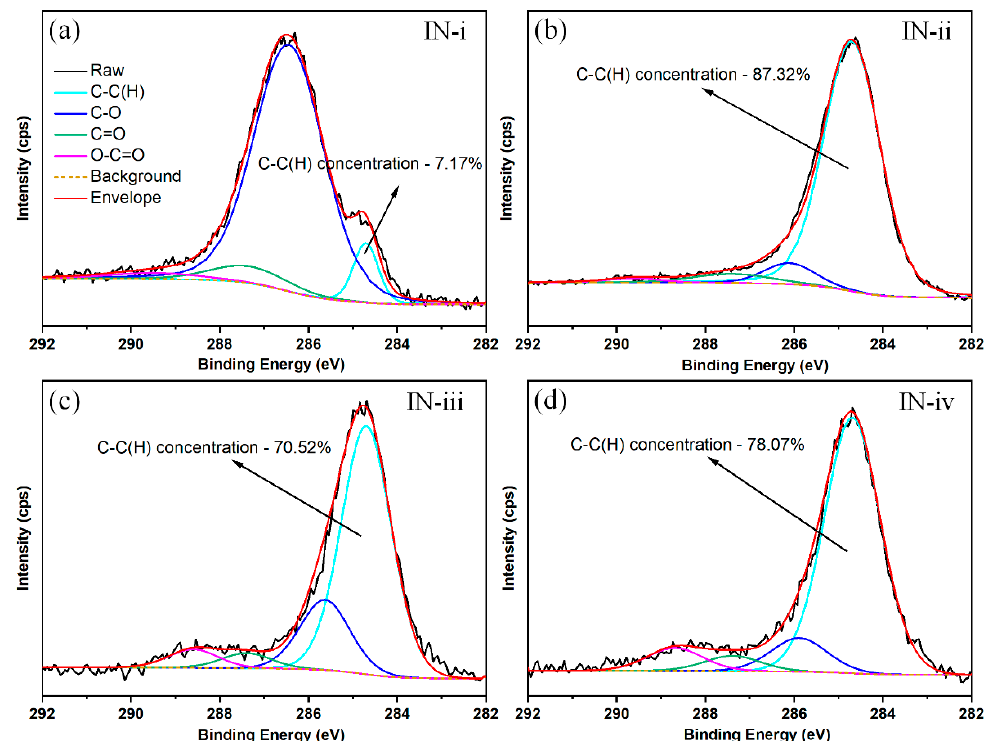
Figure 6. Deconvolutions of C 1s peaks and their corresponding relative concentration of C–C(H) group on the investigated surfaces: ( a ) fresh pristine IN718 surface, ( b ) aged pristine IN718 surface ( c ) line-patterned super-hydrophobic surface, ( d ) grid-patterned super-hydrophobic surface.